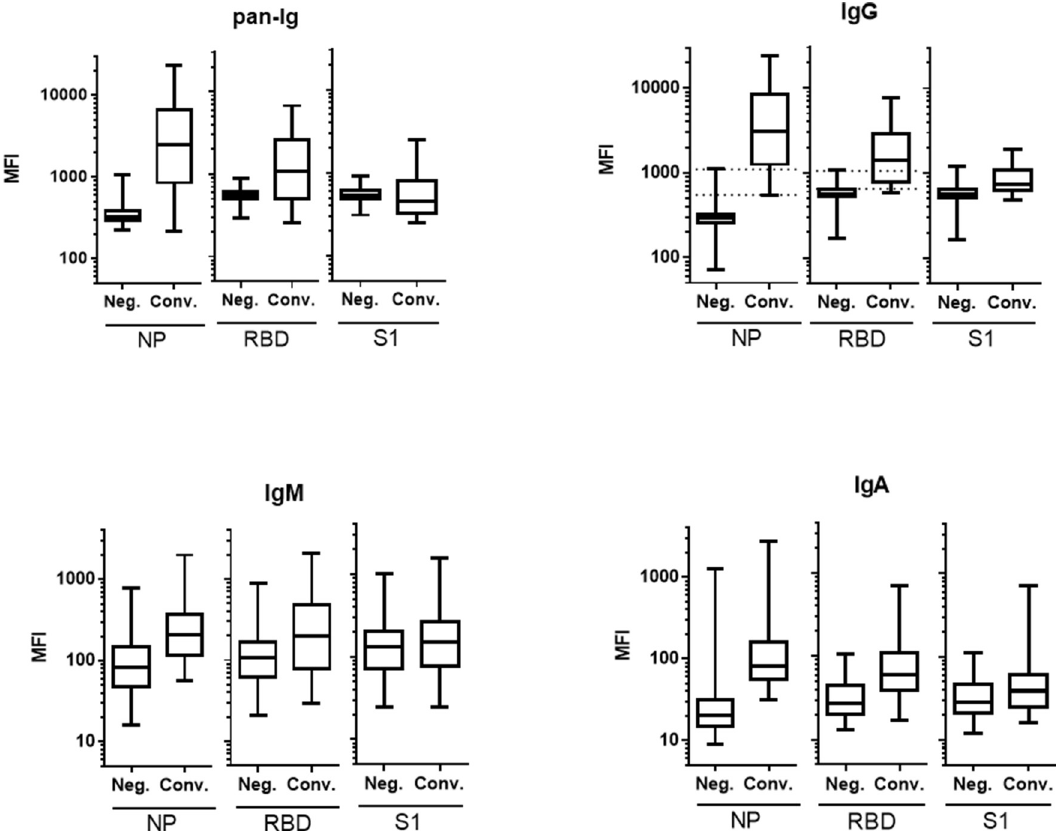
Fig 3. Comparison of antibody isotypes. The SARS-CoV-2 antigens, NP, RBD, and S1, were multiplexed in each assay run. Serum samples included samples taken pre-COVID-19, ‘Neg.’, (n = 78), and samples from convalescent patients, ‘Conv.’ (n = 41). The assays were detected with antibodies against either pan-Ig, IgG, IgM or IgA. Dashed lines represent the positive (upper line) and negative (lower line) cut-off values for RBD and NP IgG MFI. Values between the lines are considered ‘equivocal’.